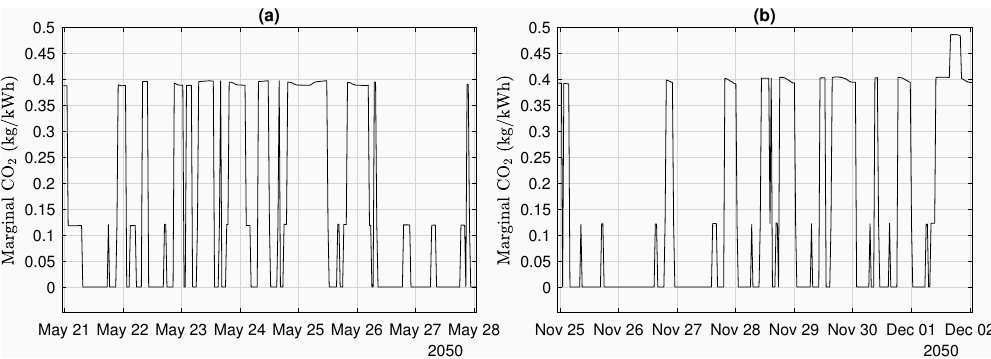
Figure 7. Generators dispatched in Community Renewables scenario, for ( a ) 21–28 May 2050, and ( b ) 25 November–2 December 2050. 4 kW PV, 7.5 kWh battery, C-rate limit 0.3 C.